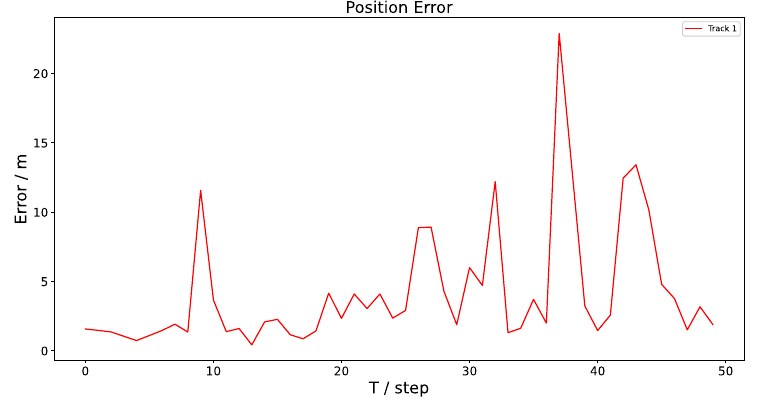
Figure 13. Single-target track in the Cartesian coordinate system (CMKF-REMTT).